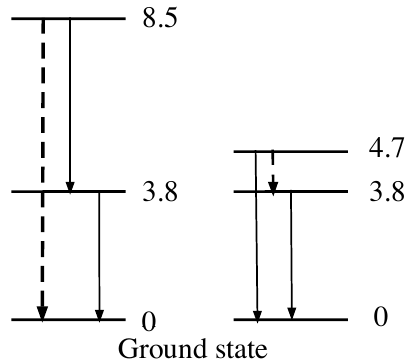
Figure 5: The interpretation of Lawrence et al. result.